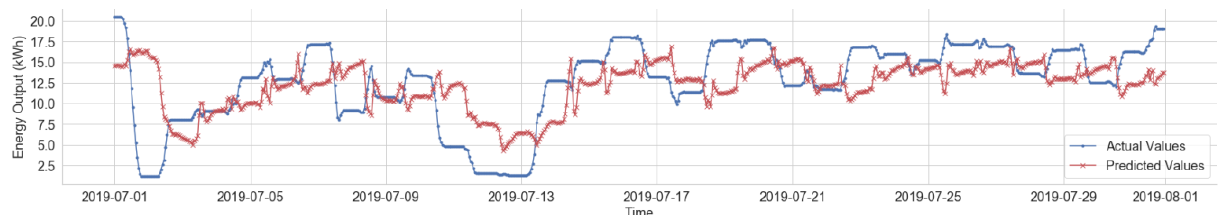
Figure 13: Snapshot of 24-hour predictions for 1 month: July,